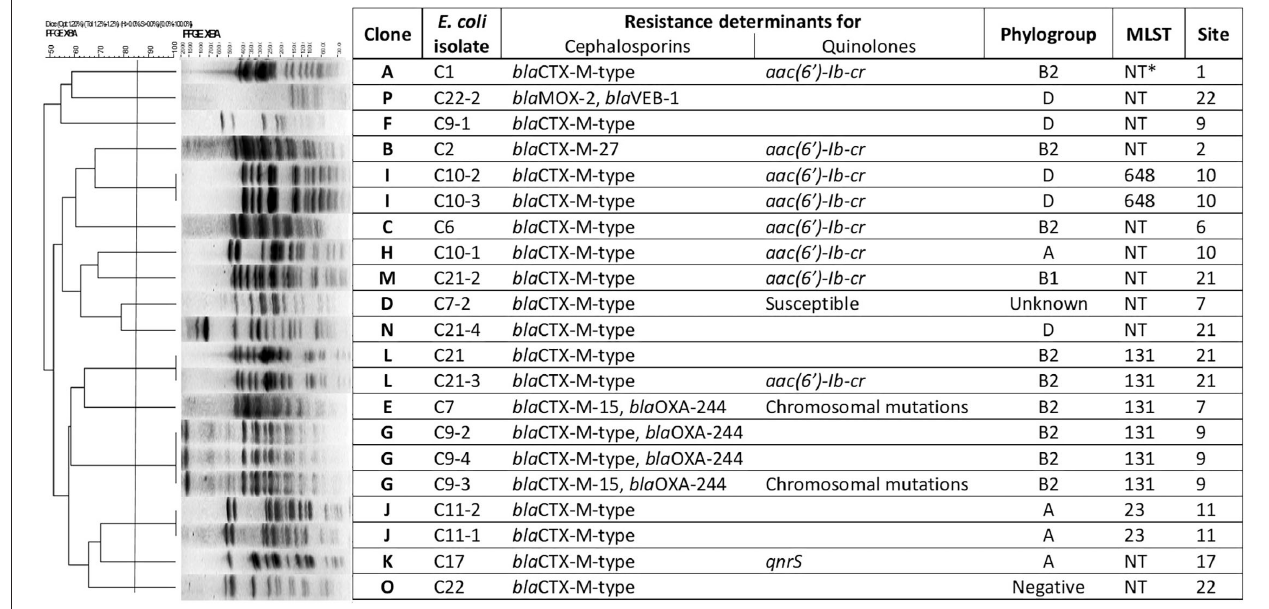
FIGURE 8 | Cluster analysis of the 21 ES β L-producing E. coli isolates. *NT, Not